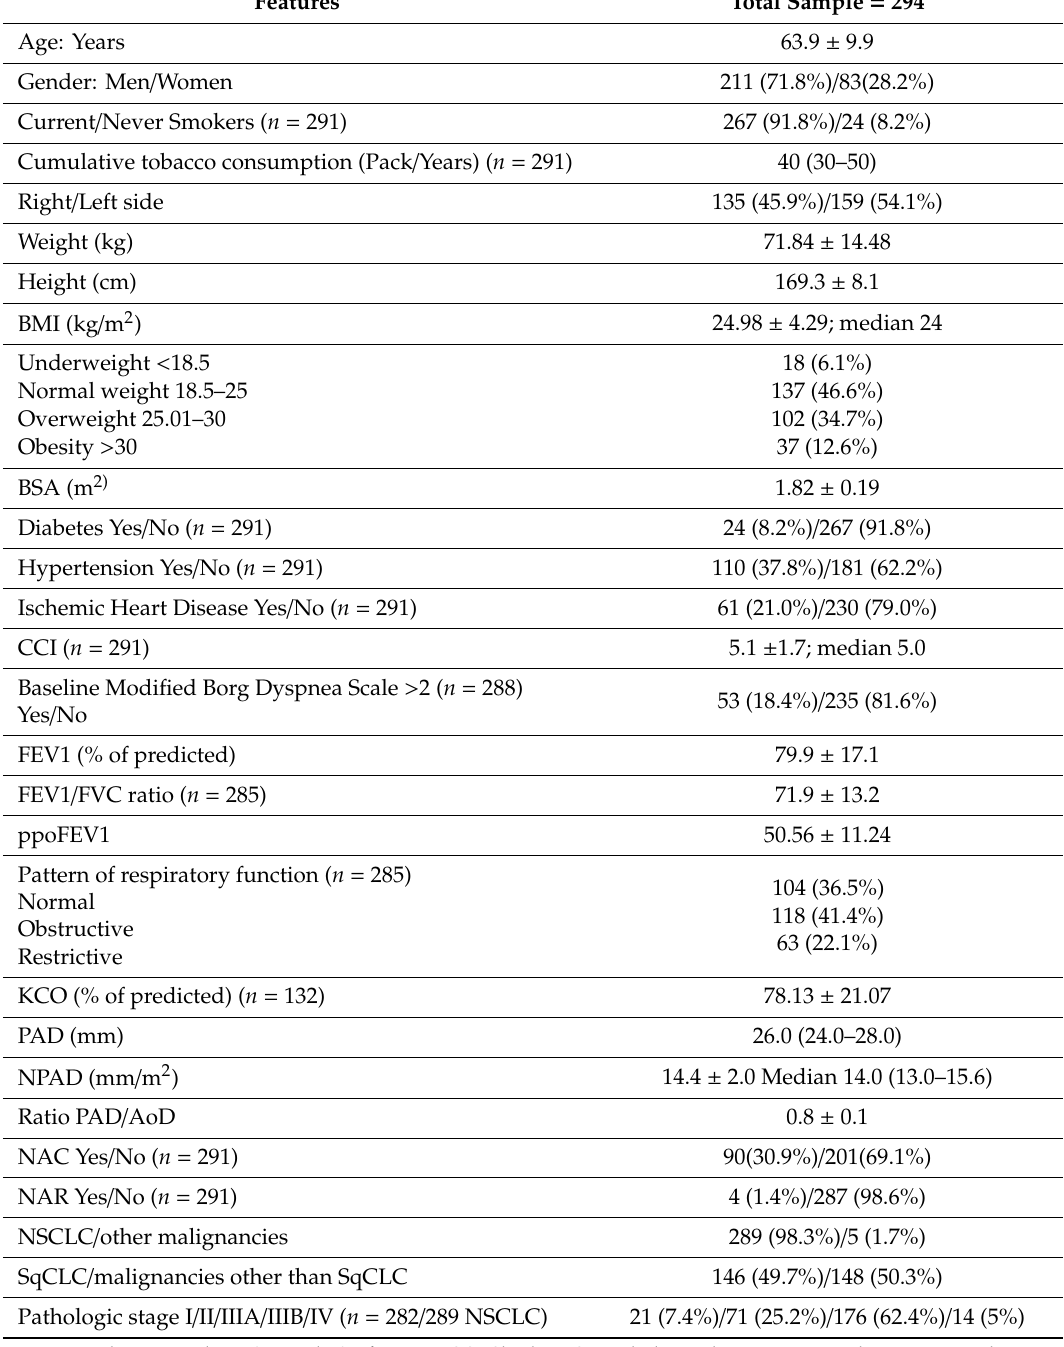
Table 1. Patients (cid:48)